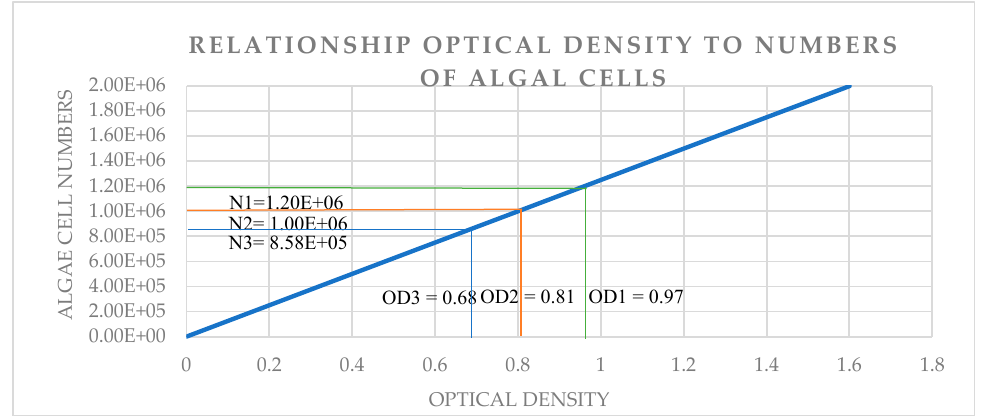
Figure 2. Standard curve based on r: the relationship of optical density to numbers of algal cells (linear regression). N1—number of cells after 24 h, N2—number of cells after 48 h, N3—number of cells after 72 h, OD1—optical density after 24 h, OD2—optical density after 48h, OD3—optical density after 72 h.